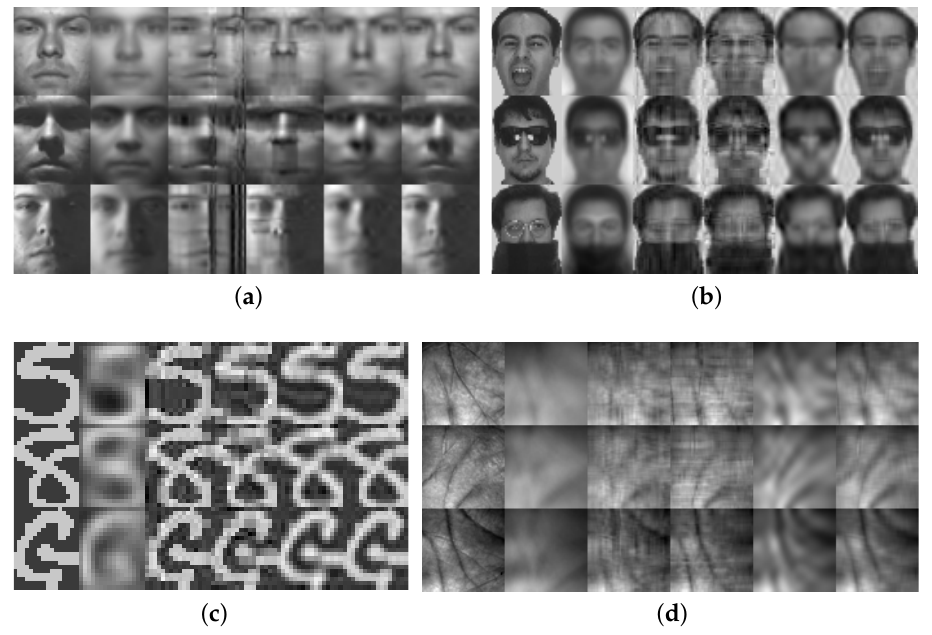
Figure 6. The reconstructed images of the five algorithms. In each subfigure, the first column shows the original images while the remaining columns show the reconstructed images of PCA, 2DPCA, A2DPCA, ( 2D ) 2 PCA and DB2DPCA, respectively. ( a ) Extended Yale B face database. ( b ) AR